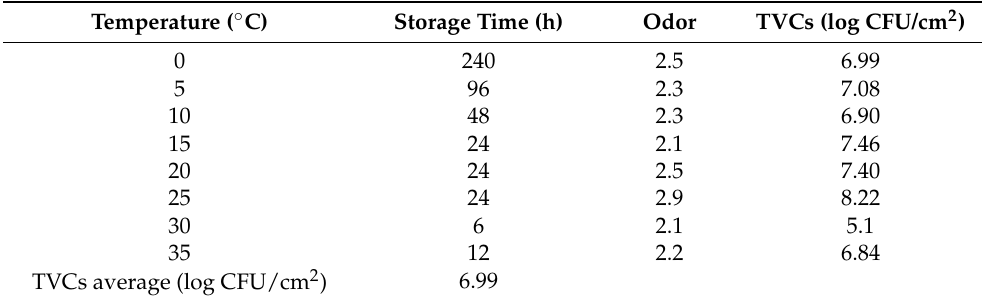
Table 1. Sensory scores and TVCs counts for chicken thigh samples corresponding to the sensory rejection time at each storage temperature.